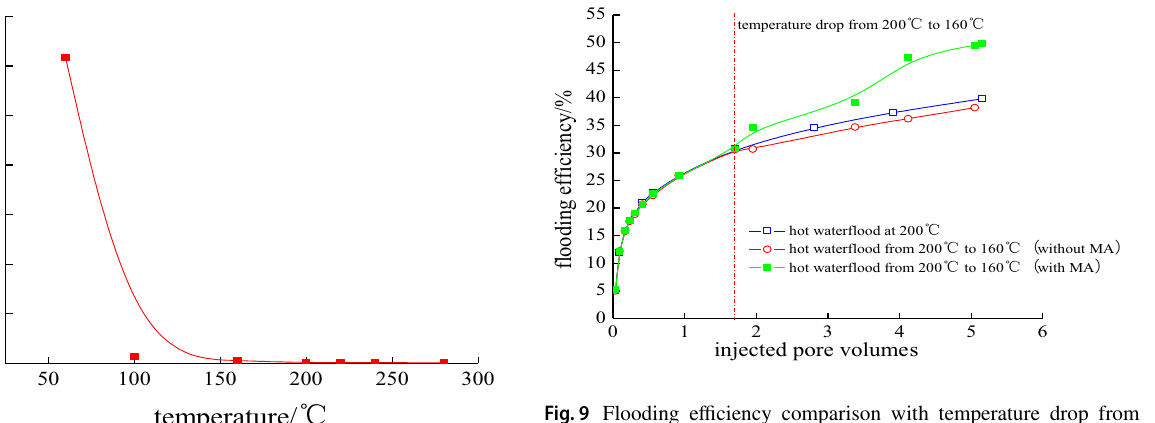
Fig. 9 Flooding efficiency comparison with temperature drop from